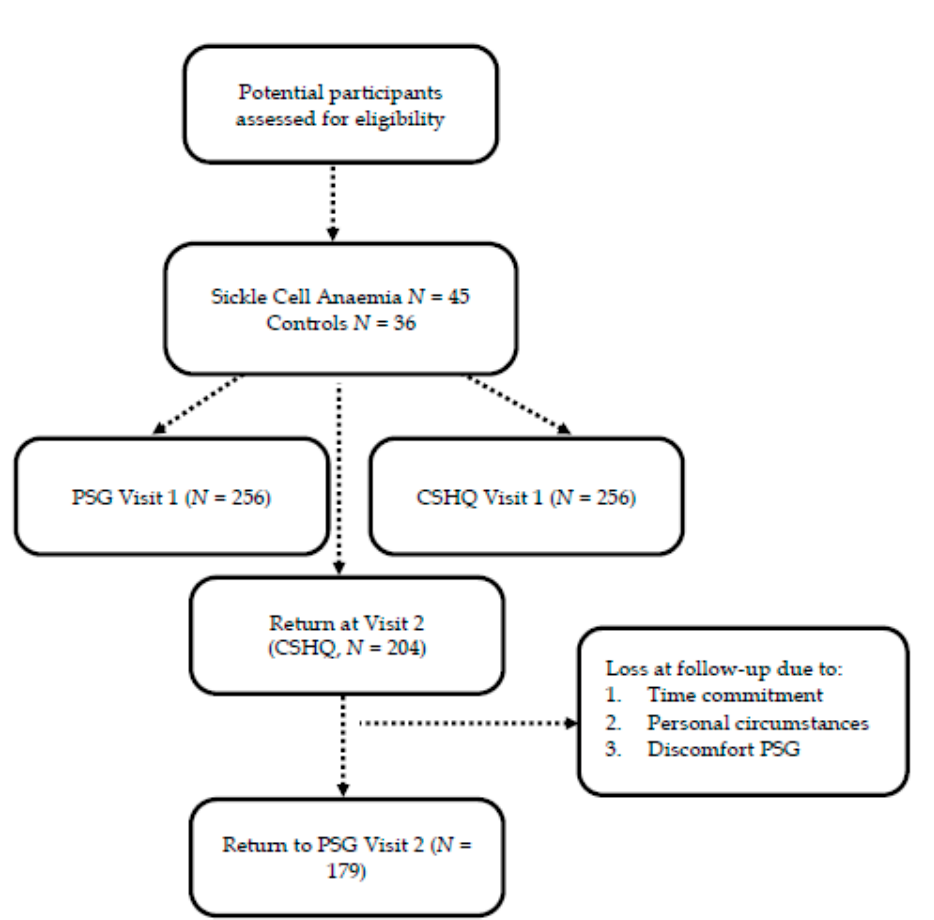
Figure 1. Flowchart. Note. CSHQ = Children’s Sleep Habit Questionnaire, PSG = Polysomnography.